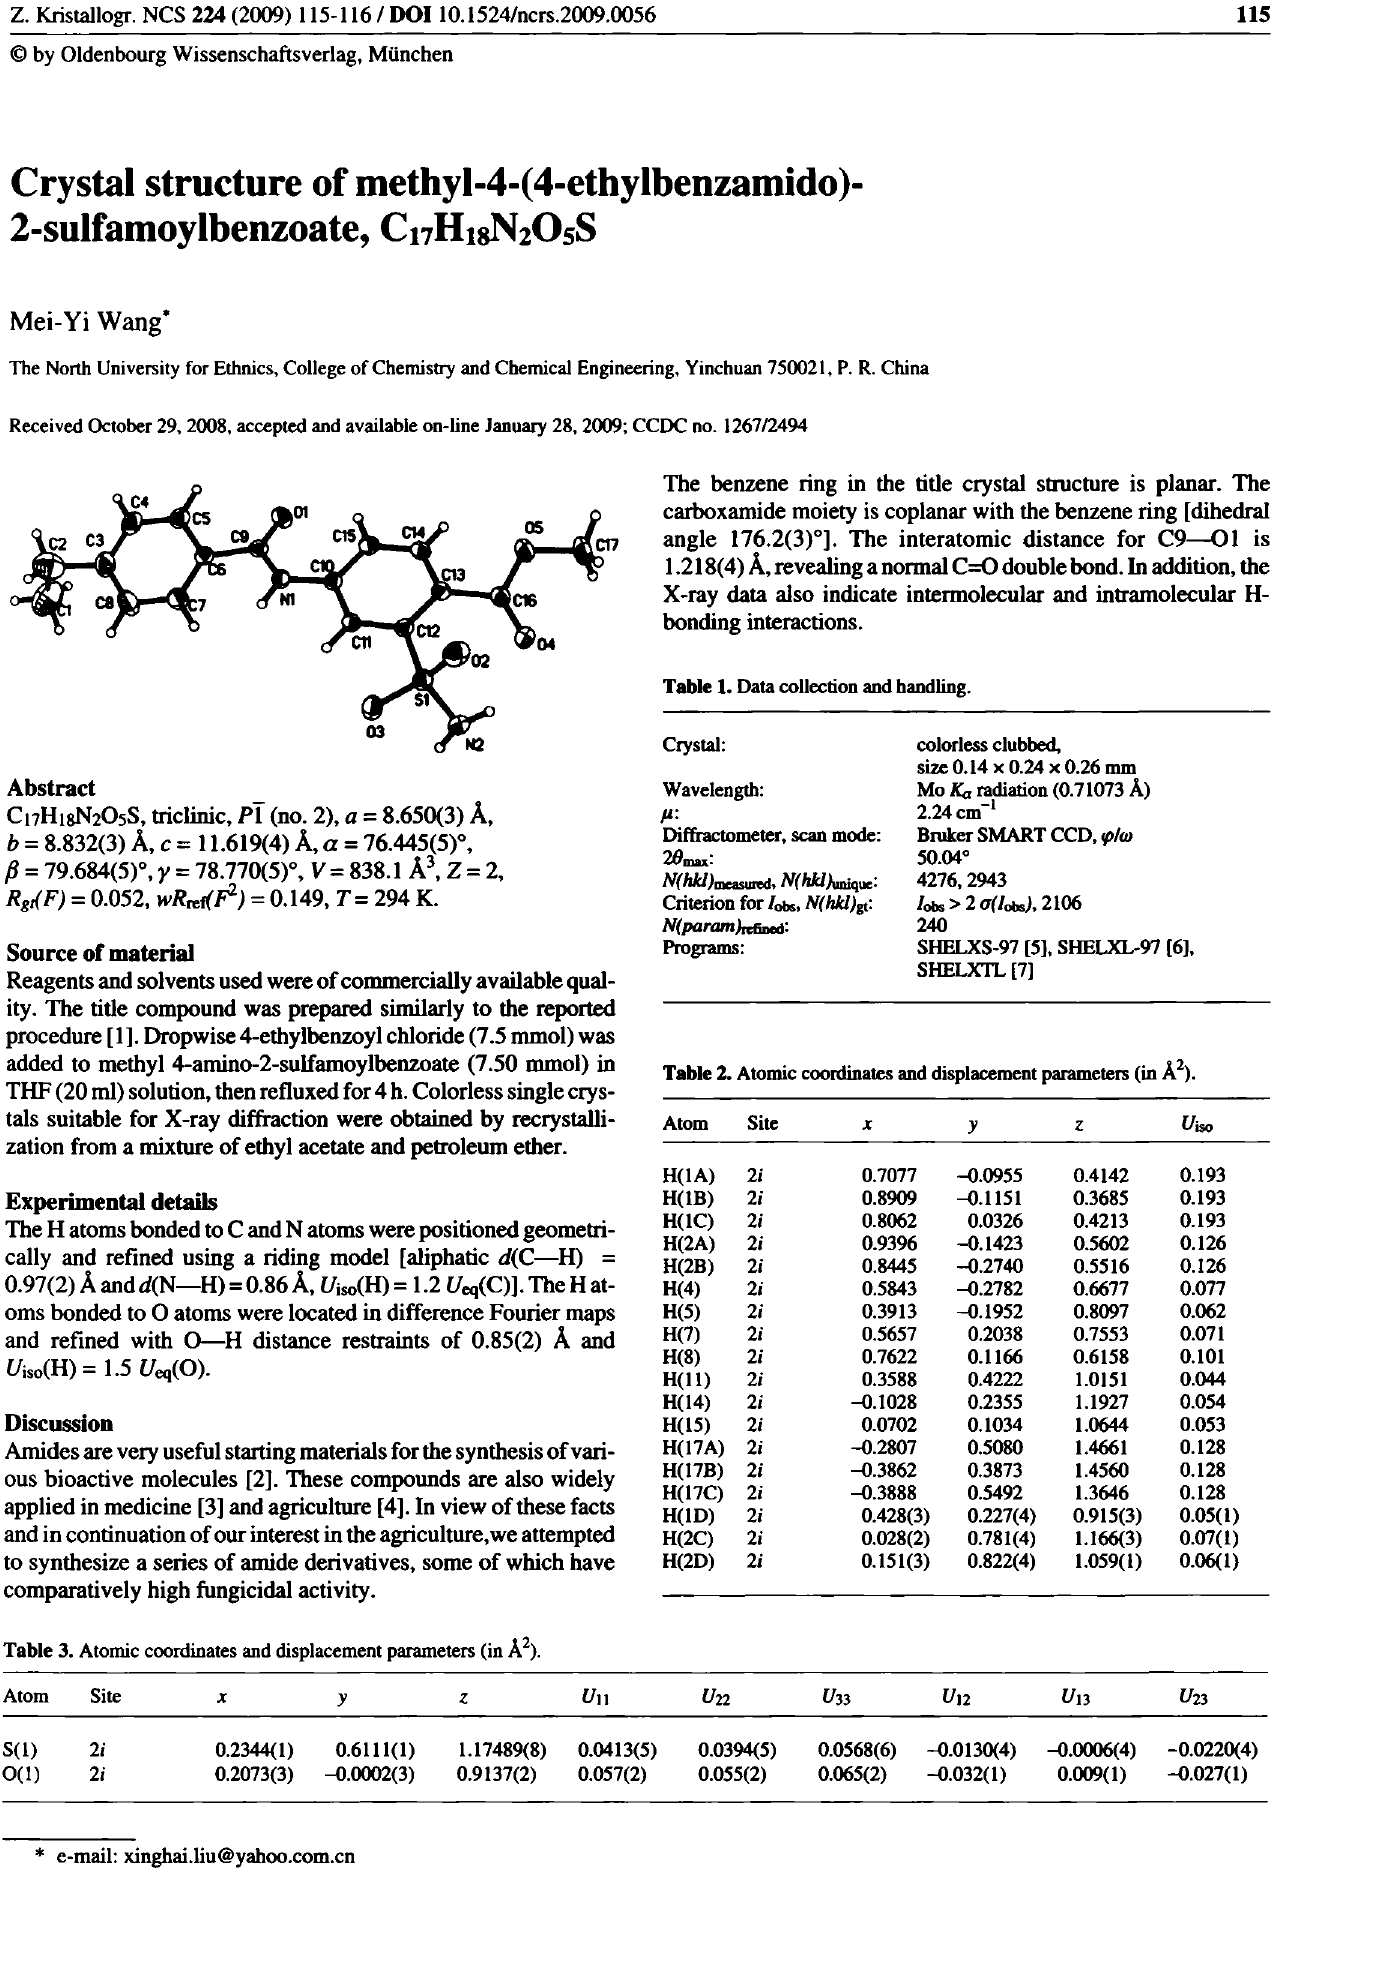
Table 3. Atomic coordinates and displacement parameters (in Â 2 ).